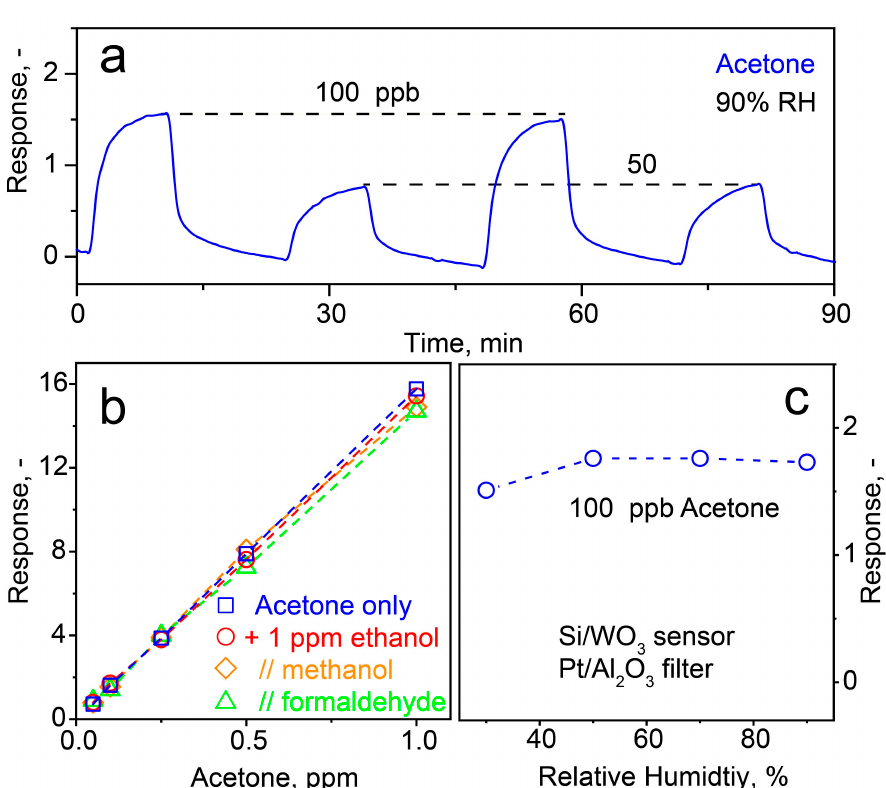
Figure 6. ( a ) Detector (i.e., Si/WO 3 sensor with Pt/Al 2 O 3 filter at 40 °C) response to consecutive exposures to 100 and 50 ppb acetone at 90% RH. ( b ) Detector response to 0.05, 0.1, 0.25, 0.5 and 1 ppm acetone as single analyte (squares) and in mixture with 1 ppm ethanol (circles), methanol (diamonds) and formaldehyde (triangles) at 90% RH. ( c ) Detector response to 100 ppb acetone at 30–90% RH.